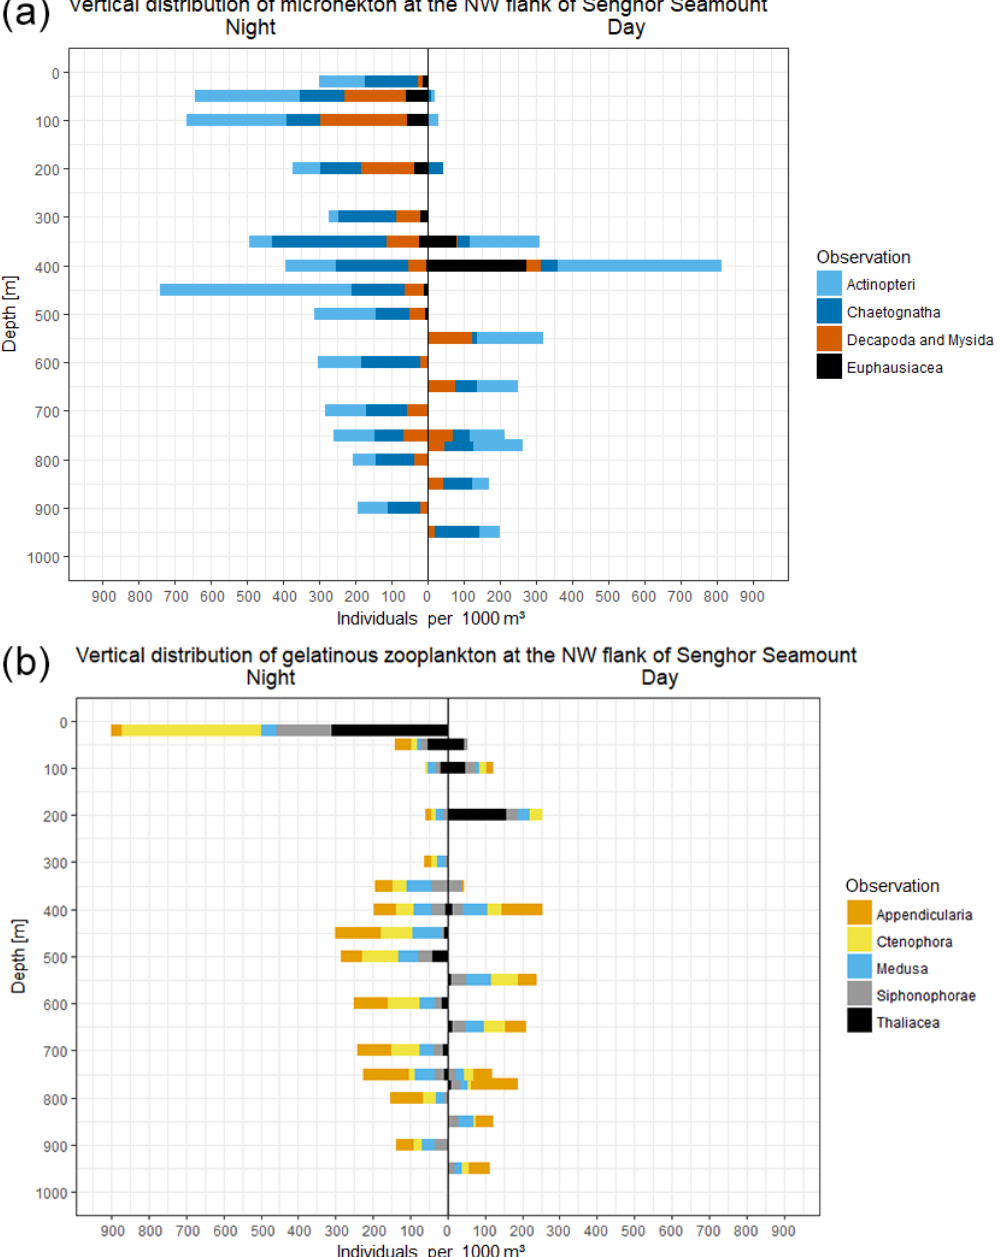
Figure 4. Day and night comparison of faunal observations obtained by PELAGIOS at the northwest flank of Senghor Seamount: (a) fishes, krill, chaetognaths, and decapods; (b) gelatinous zooplankton